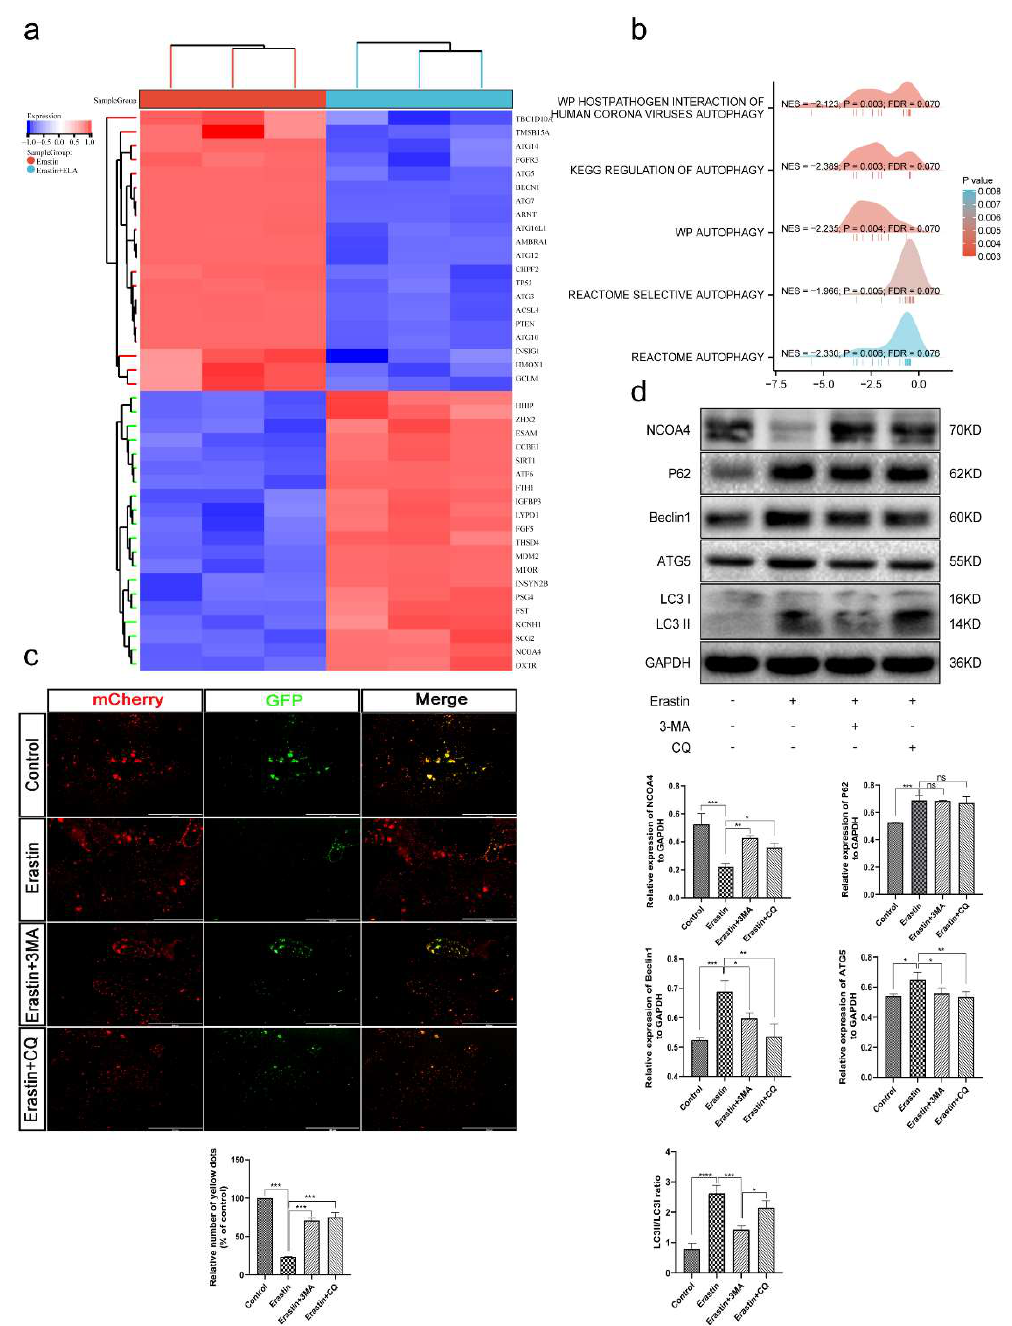
Figure 5. Ferroptosis is an autophagy-dependent form of cell death. ( a ) Heatmap of the significant differences expressed genes between the experimental group (Erastin+Elabela) and the control group (Erastin). ( b ) GSEA analysis of genes. ( c ) HTR-8/Svneo cells was transfected with Ad-mCherry-GFP-LC3B adenovirus (20 MOI) for 24 h. Next, Cells were pretreated with 3-MA(2 mM), CQ (50 μm) for 1 h, respectively, and Erastin (5 μm) was added for 12 h. Fluorescence images of GFP/mCherry spots were examined; n = 3. Scale bars: 400 μm. One-way ANOVA and Tukey’s multiple comparison test. ( d ) HTR-8/Svneo cells were pretreated with 3-MA(2 mM), CQ (50 μm) for 1 h, respectively, and Erastin (5 μm) was added for 12 h, and protein levels of NCOA4, P62, Beclin1, ATG5, and LC3were examined by Western blotting; n = 3, one-way ANOVA and Tukey’s multiple comparison test. All data are presented as the means ± SEM. ns, non-significant; * p < 0.05; ** p < 0.01; *** p < 0.001; **** p < 0.0001.